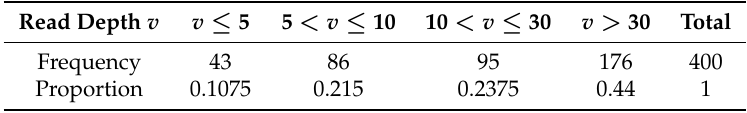
Table 3. Distribution of read depths at rs